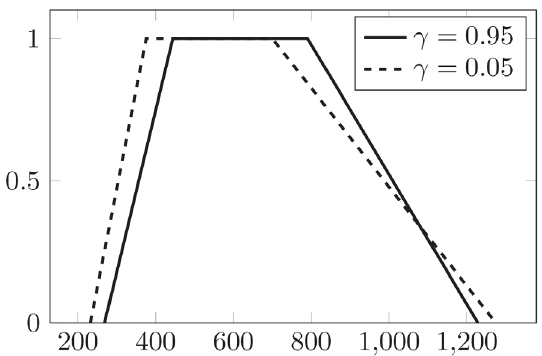
Figure 9. Fuzzy total cost when c ~ 0 : 95 and ª ~ 0 : 05 .